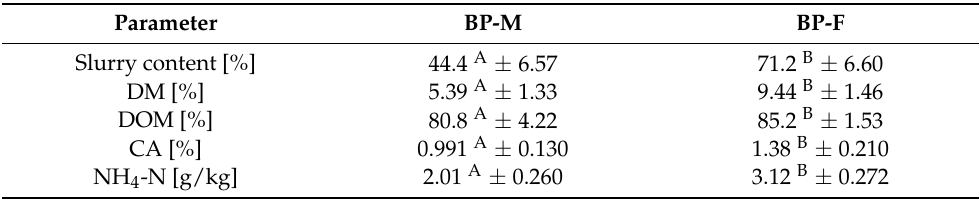
Table 3. The basic composition of the input biomass in the biogas plants.